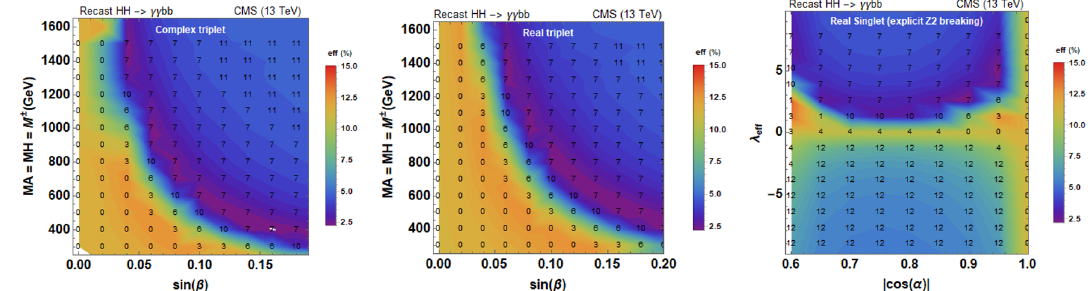
Figure 10 . Efficiency maps for the signal region of the CMS-like analysis applied to the triplet and singlet benchmarks we consider. The markers superimposed correspond to the closest shape benchmark. Details are given in the